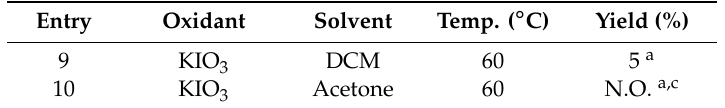
Table 2. Reaction scope of cyclization of the thiosemicarbazide.